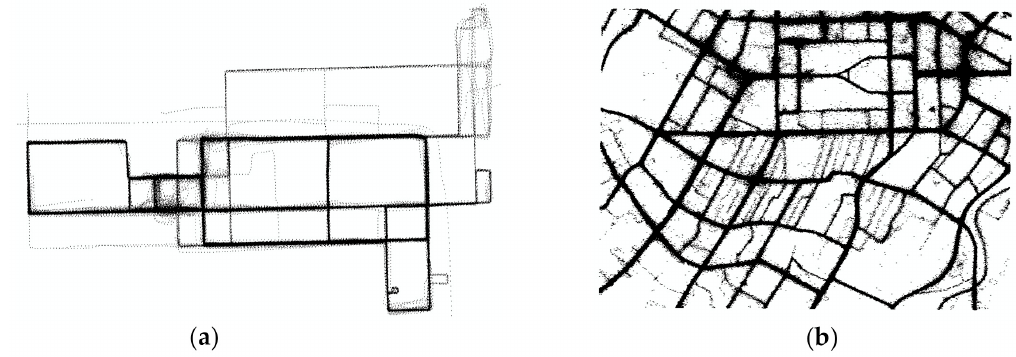
Figure 9. ( a ) GPS trajectory dataset for Chicago; and ( b ) GPS trajectory dataset for Chengdu.